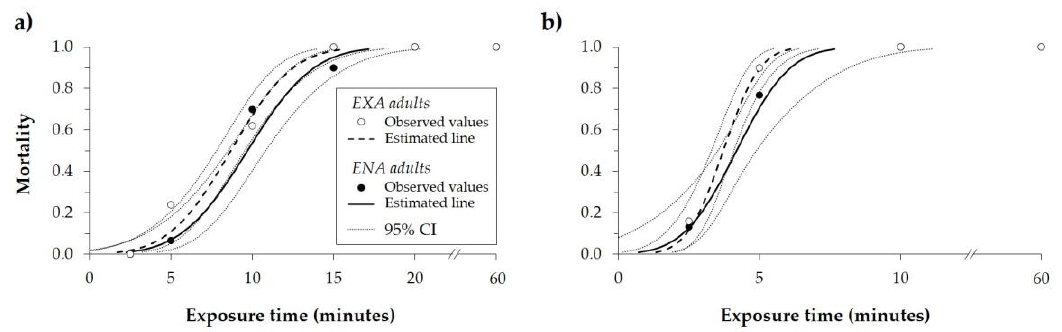
Figure 2. Mortality rate (observed values, estimates of the curves, and 95% confidence interval (CI)) of Halyomorpha halys adults (EXA and ENA) calculated after different exposure times at the constant temperature of ( a ) 47.5 °C and ( b ) 50.0 °C.